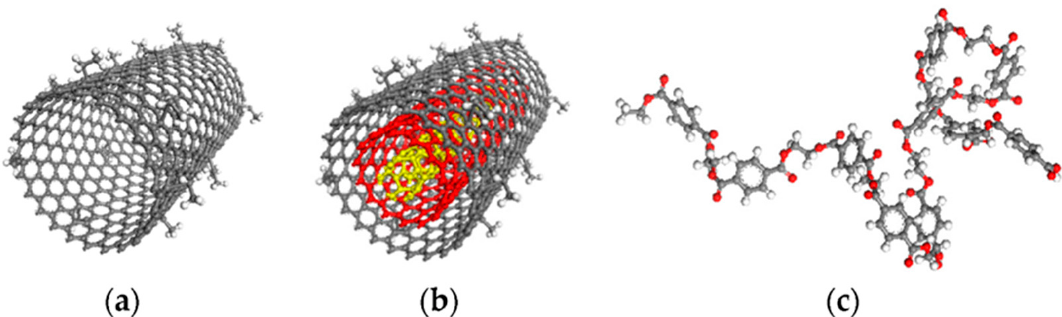
Figure 13. Molecular models of ( a ) (23, 0) single-walled carbon nanotubes (SWNT), ( b ) (23, 0), (14, 0), (5, 0) multi-walled carbon nanotubes (MWNT), and ( c ) polyethylene terephthalate (PET) chain. Reprinted with permission from Ref. [124]. Copyright 2021 by the authors and licensee MDPI, Basel, Switzerland.